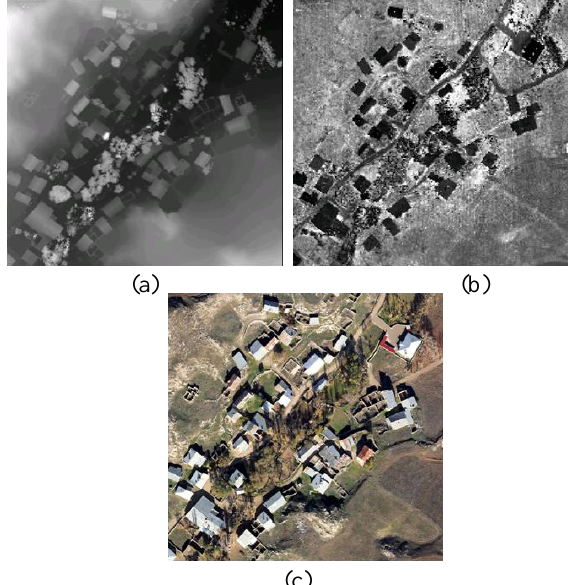
(c) Figure 2. DSM(a), intensity image (b) and ortho-image(c) of study